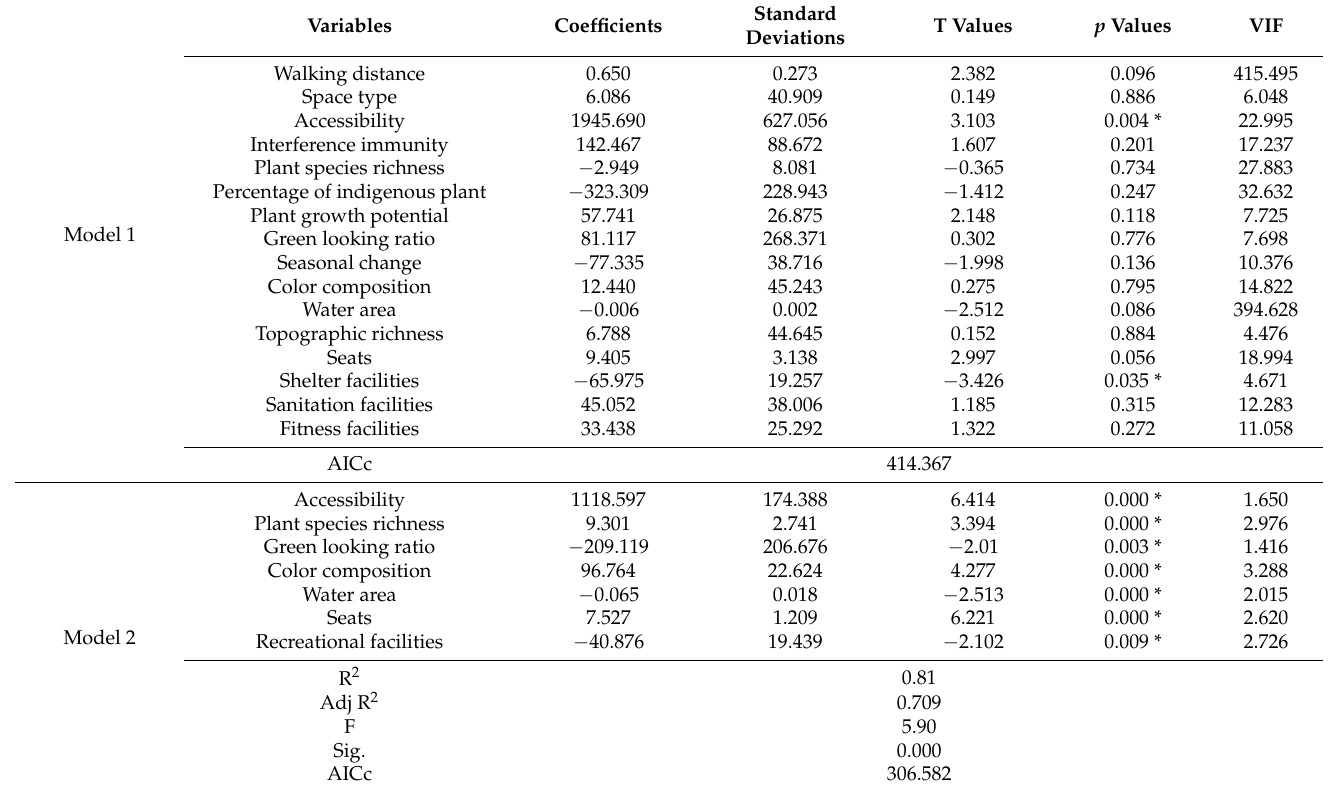
Table 3. Results of the Linear Regression Analysis-Tourists. * p <